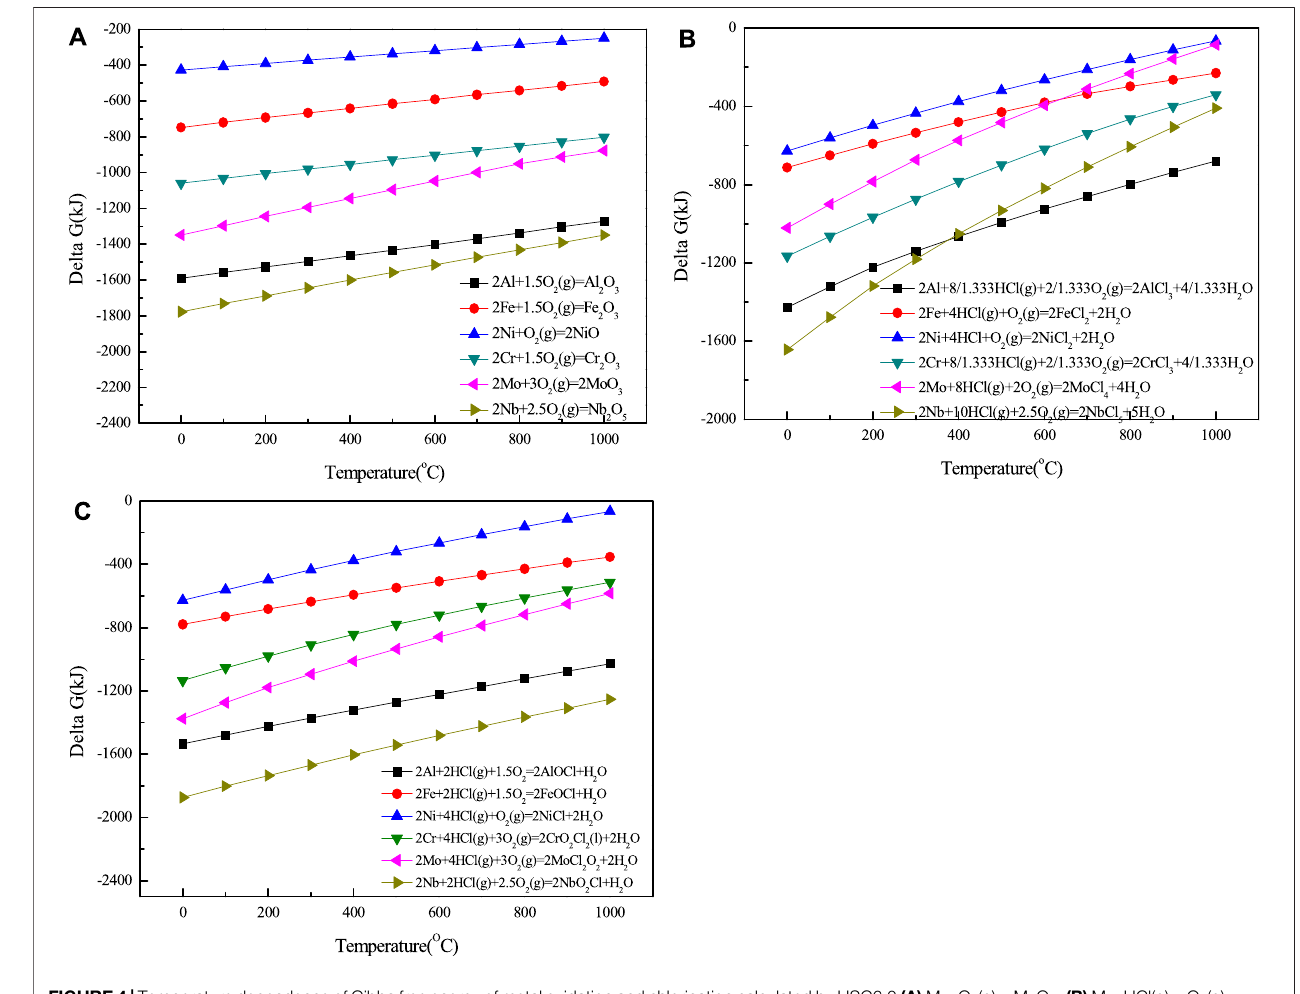
FIGURE4| Temperature dependence ofGibbsfreeenergyofmetal oxidation and chlorination calculated byHSC6.0 (A) M+O 2 (g) (cid:2) MxOy; (B) M+HCl(g)+O 2 (g) (cid:2) MCl (cid:2) MO x + H 2 O; (C) M + HCl(g) + O 2 (g) x Cl y + H 2 O.